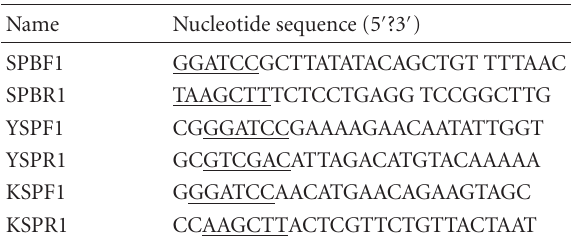
Table 1. Primers used in PCR reactions. The nucleotides repre- senting various restriction sites are